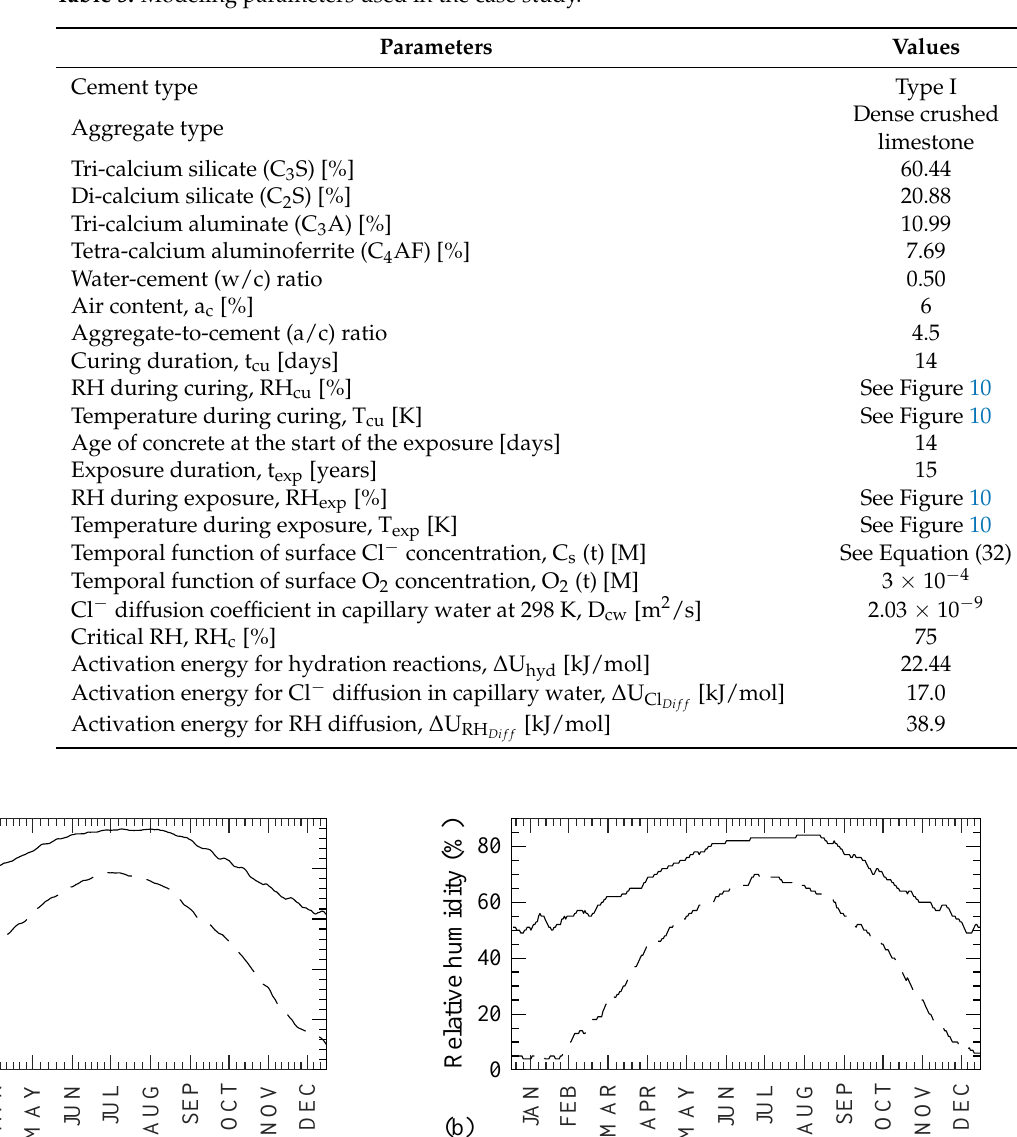
Table 5. Modeling parameters used in the case study.